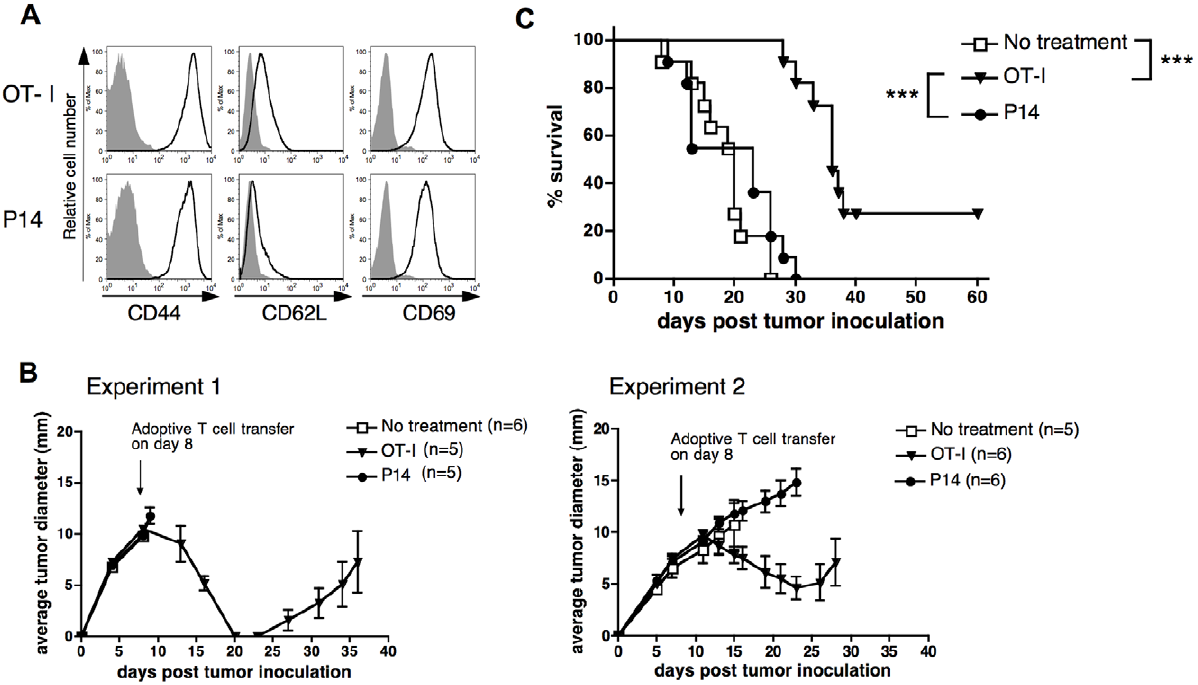
Figure 2. Antigen specificity of tumor control by reactivated memory T cells. (A) Phenotypes of in vitro generated reactivated OT-I and P14 memory cells. T cells were surface stained for the expression of CD44, CD62L and CD69 (open areas) overlaid on the background staining with isotype controls (shaded areas). Histograms were gated on the CD8 + population. (B) Mice bearing eight-day E.G7 tumors were given 3 6 10 6 reactivated OT-I or P14 memory cells i.v. or no cell transfer, as indicated. Average tumor growth is shown for two independent experiments, with (n) indicating number of mice per group. Tumor growth curves were discontinued at the time when the first animal in the group succumbed to the disease. (C) Survival data for tumor bearing mice were pooled from two independent experiments. Survival curves were analyzed by the LogRank test, with ***P , 0.001 .